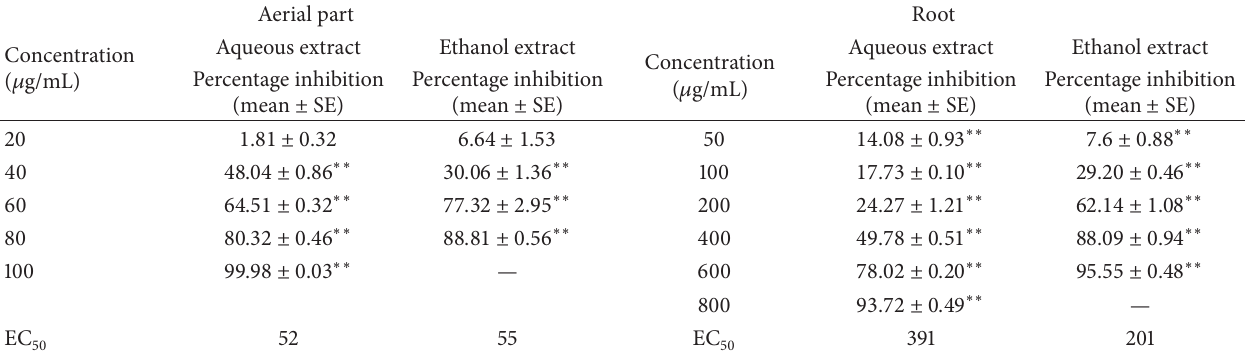
Table 2: Superoxide radical scavenging activity of P. fraternus aqueous and ethanolic extracts of aerial part and root. Aerial part Root